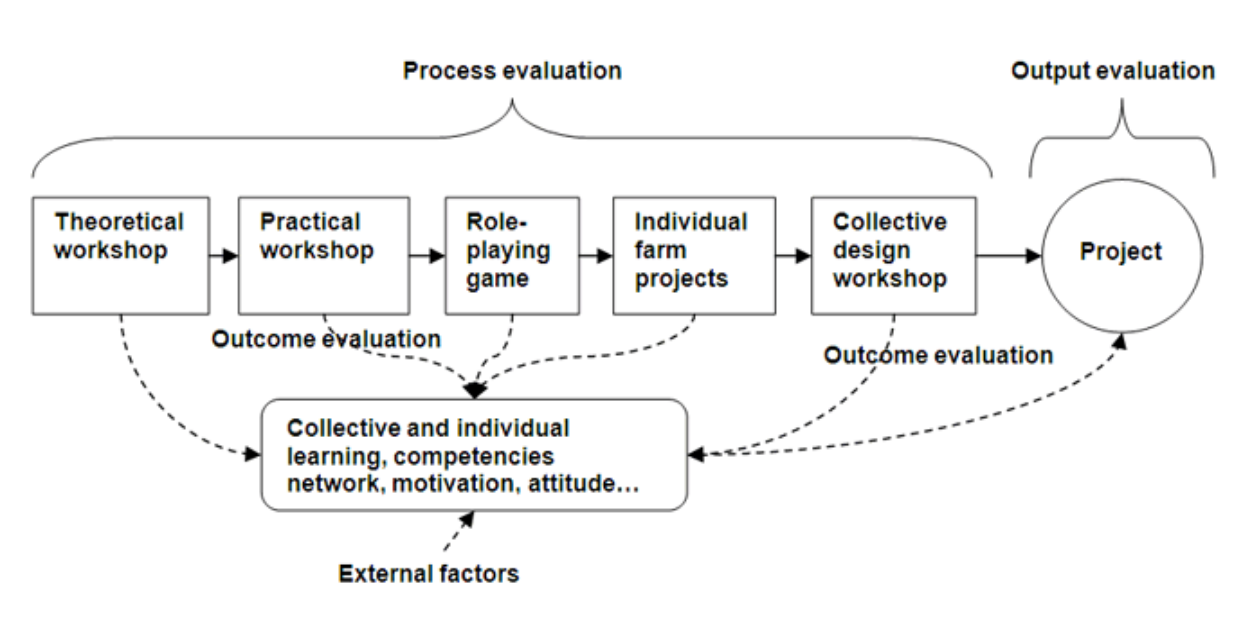
Fig. 1 . The aim of the evaluation was to judge how the process was led and what outputs and outcomes were